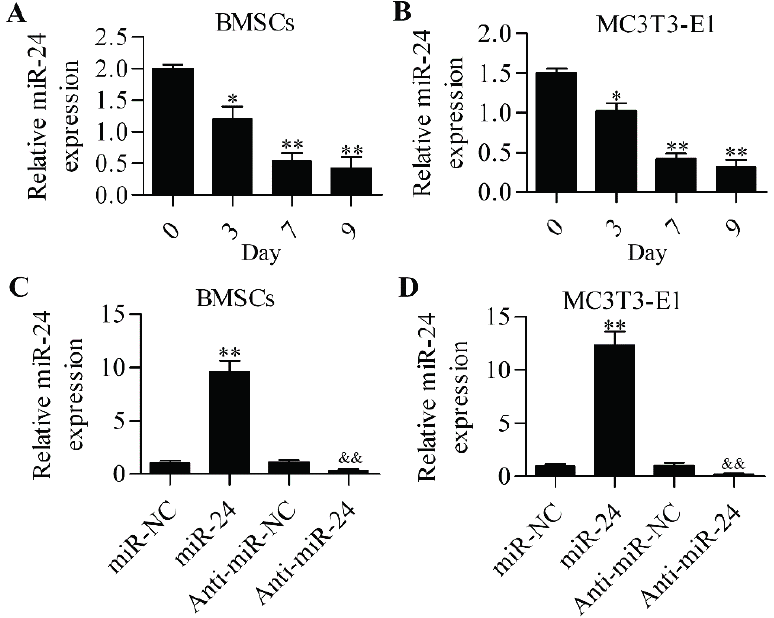
Figure 1. Detection of the expression of miR-24. RT-qPCR was performed to detect the expression level of miR-24 during osteogenic differentiation in BMSCs ( A ) and MC3T3-E1 cells ( B ). N = 3, * p < 0.05 ** p < 0.01 vs. day 0. RT-qPCR analysis of miR-24 expression in miR-24 or anti-miR-24 transfected BMSCs ( C ) and MC3T3-E1cells ( D ). Cells were transfected with 20 nM miR-24 or anti-miR-24 for 48 h. miR-NC or anti-miR-NC was used as the control for miR-24 or anti-miR-24, respectively. N = 3, ** p < 0.01 vs. miR-NC; and && p < 0.01 vs.